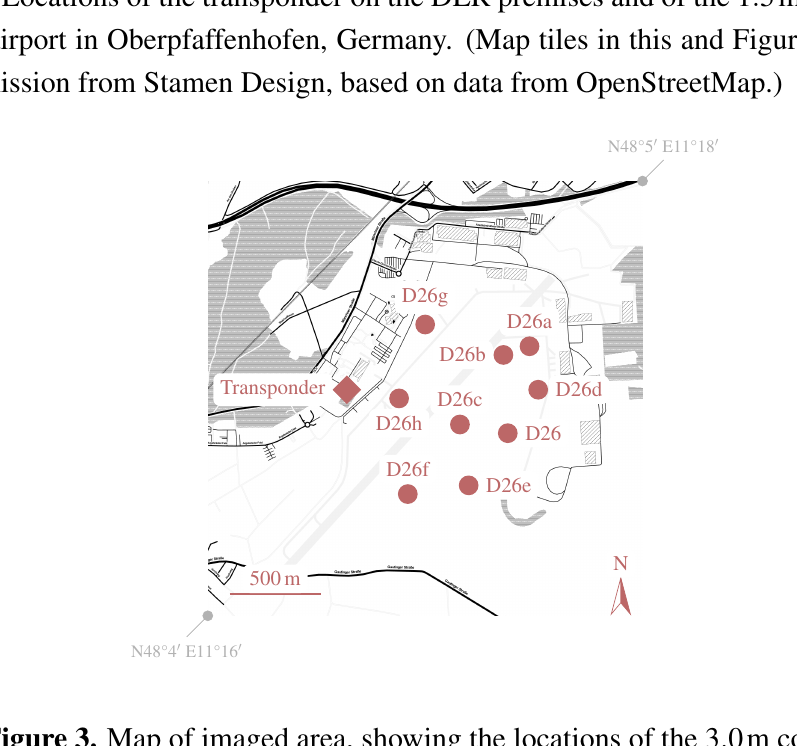
Figure 3. Map of imaged area, showing the locations of the 3 . 0m corners.